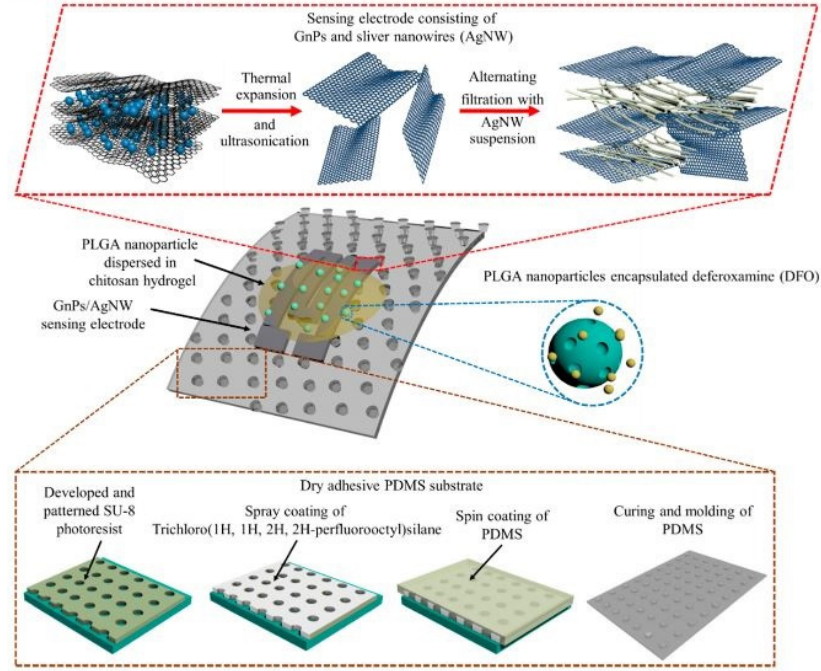
Figure 9. Illustration of the different components present in the strain-sensing and drug-delivery sensors [158]. sensors